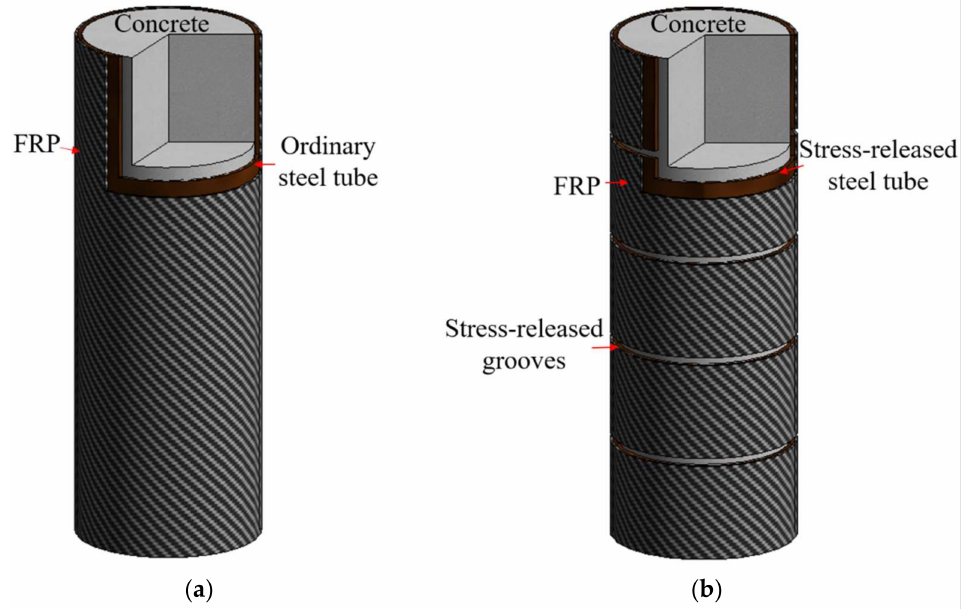
Figure 2. Diagram of two different specimens. ( a ) CFT columns ( b ) CFGCT